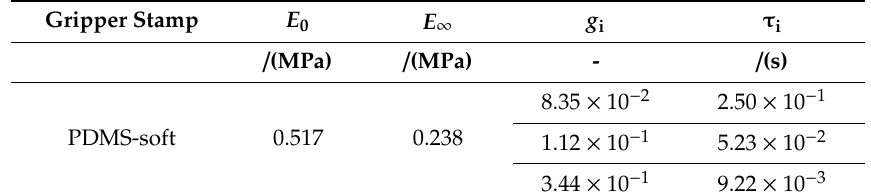
Table 1. Prony parameters of PDMS-soft formulation .